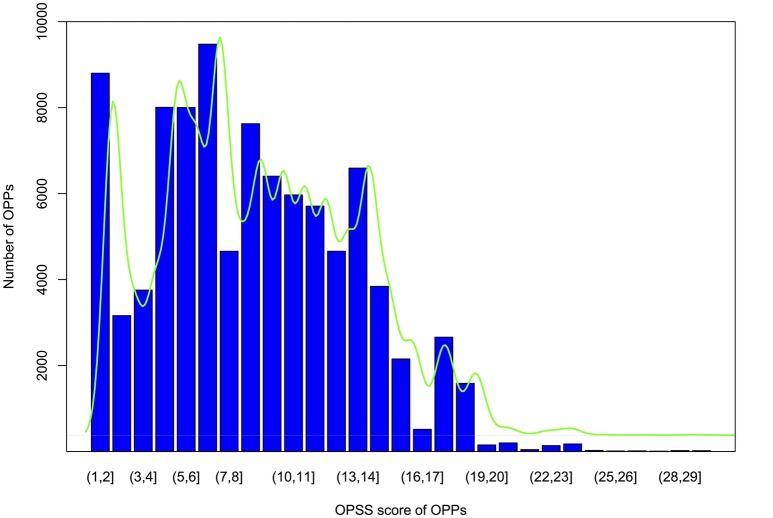
Bar plot of OPSS (orthologous protein-coding genes pair support score) distributions for OPPs (orthologous protein-coding gene pairs). Vertical axis indicates the number of OPPs, and the horizontal ordinate represents OPSS value intervals. The green curve is the fitted density.